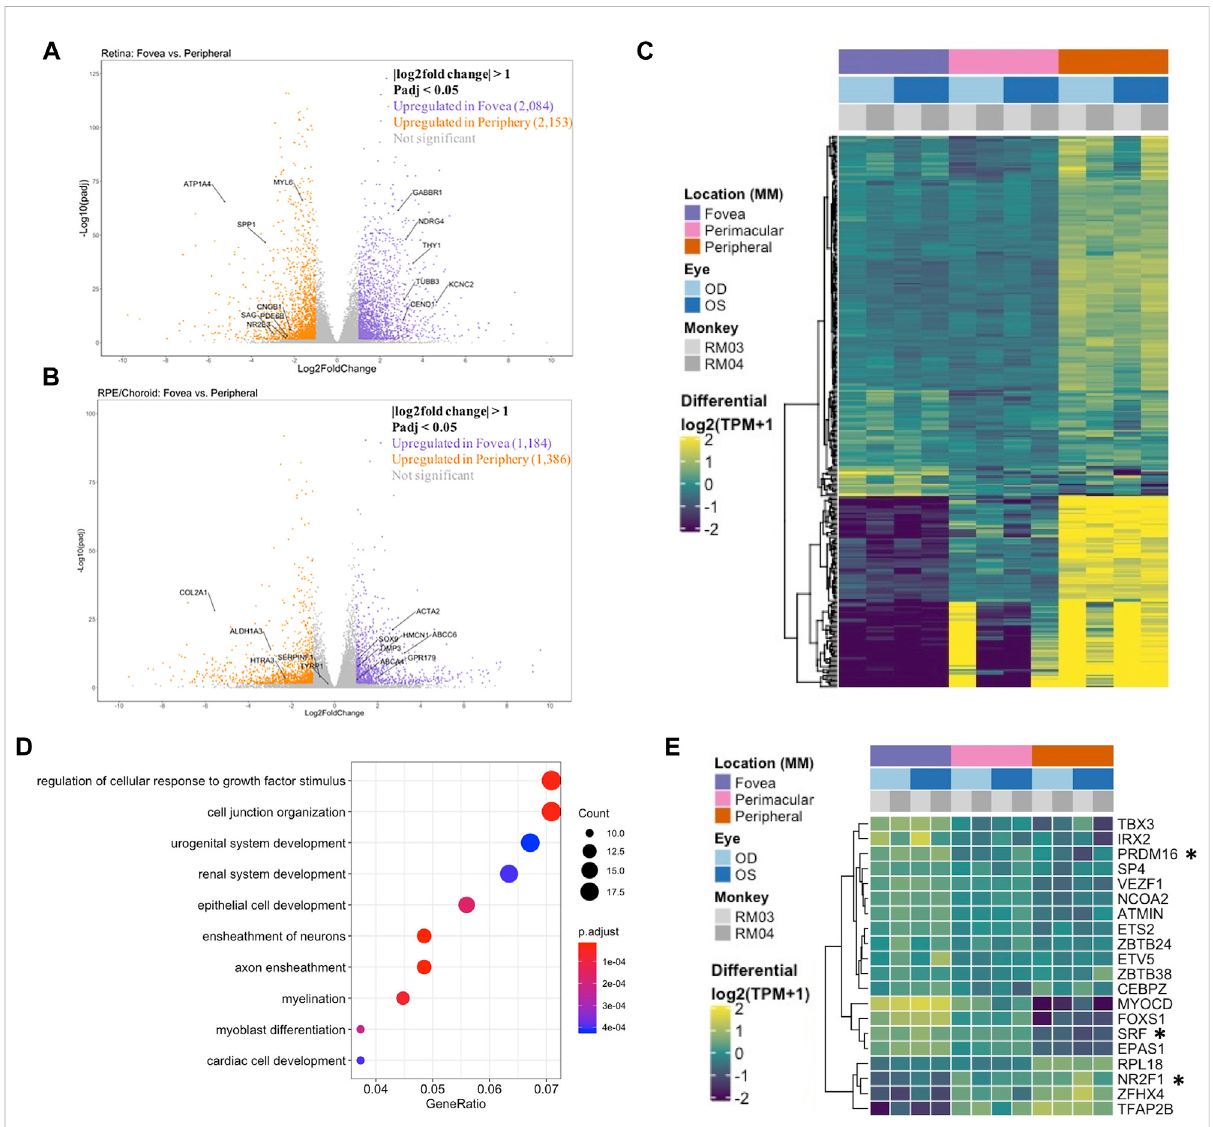
volcano plot showing RPE fovea vs. periphery differential expression, with key genes labeled, including ABCA4 and TIMP3. (C) Un fi ltered differential expression analysis of contiguously changing genes from fovea to perimacula to periphery in the RPE/choroid exhibits distinct blocks of lowly expressed genes in the fovea with a progressive increase in expression in peripheral tissues as well as blocks of genes with progressive downregulation moving outwards through the tissue despite less obvious morphologic changes in the tissue as compared to neural retina. (D) Top 10 enriched gene ontology (GO) terms from the RPE/choroid differentially expressed gene set include cell junction organization and epithelial cell development. VEGF is enriched in multiple of these ontologies and has increased expression in the macula over the periphery. (E) A subset of